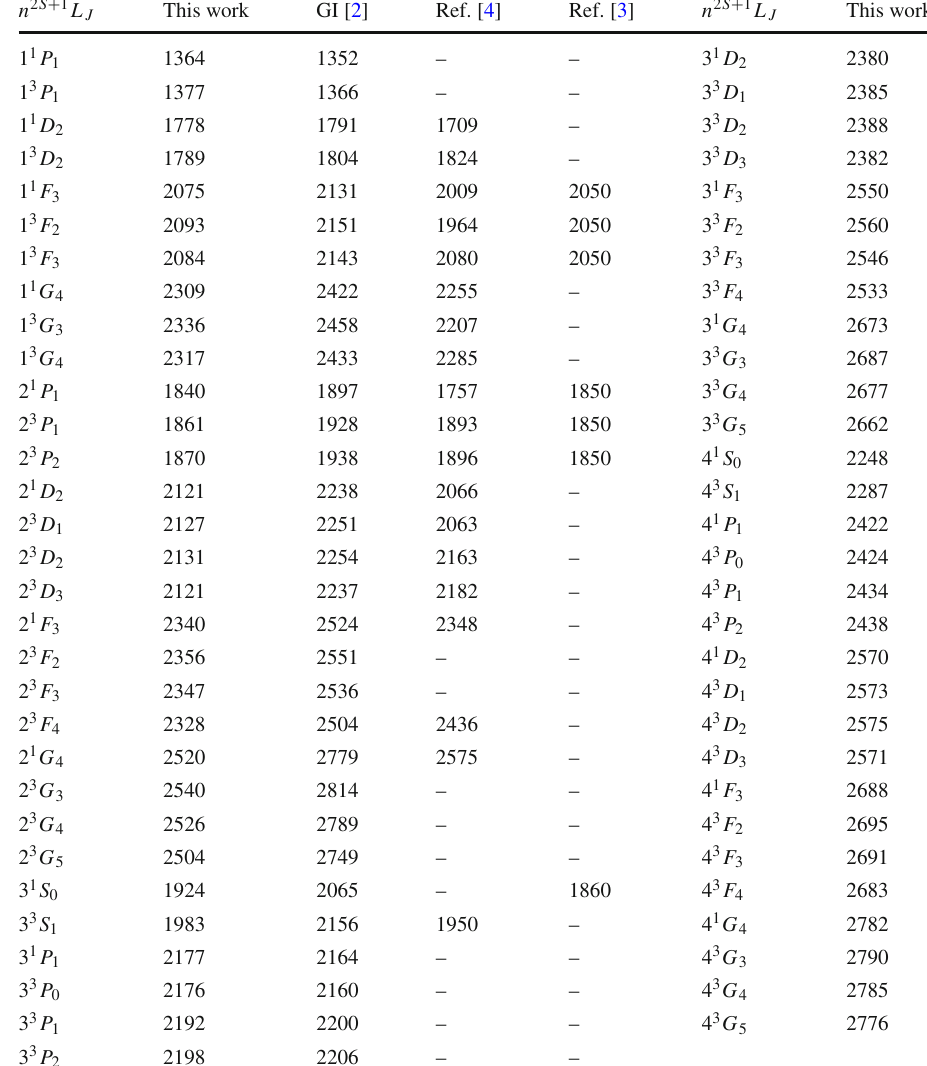
Table 3 The masses of other kaons obtained by the MGI model and comparison with those from other potential models. The unit of the mass is